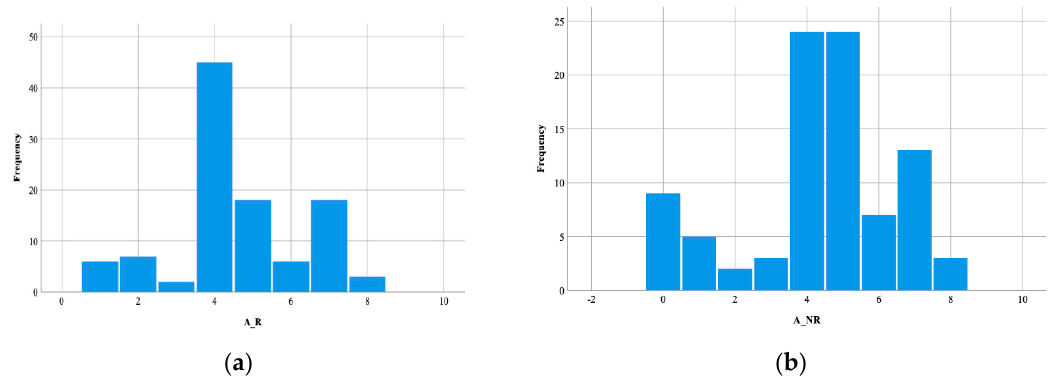
Figure 2. Histogram of ATLAS (age, treatment with systemic antibiotics, leukocyte, albumin and serum creatinine) values: ( a ) in the recurrent group; ( b ) in the non-recurrent group. A_R—ATLAS values in the recurrent group; A_NR– ATLAS values in the non-recurrent group.